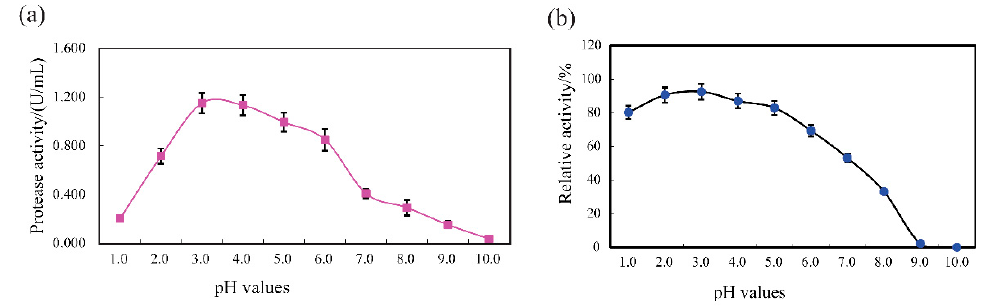
Figure 4. pH profile ( a ) and pH stability ( b ) of SVCE3(f) from squid viscera measured with casein substrate at 40 °C.